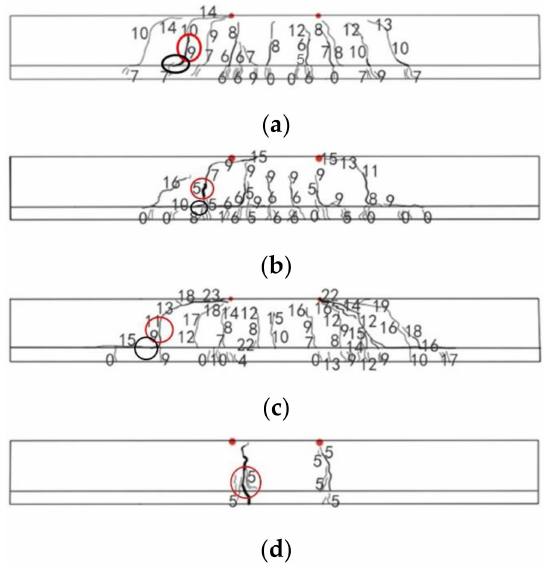
Figure 9. Crack distribution on side A surface of SSC-UHDCC beams (the two red points are loading